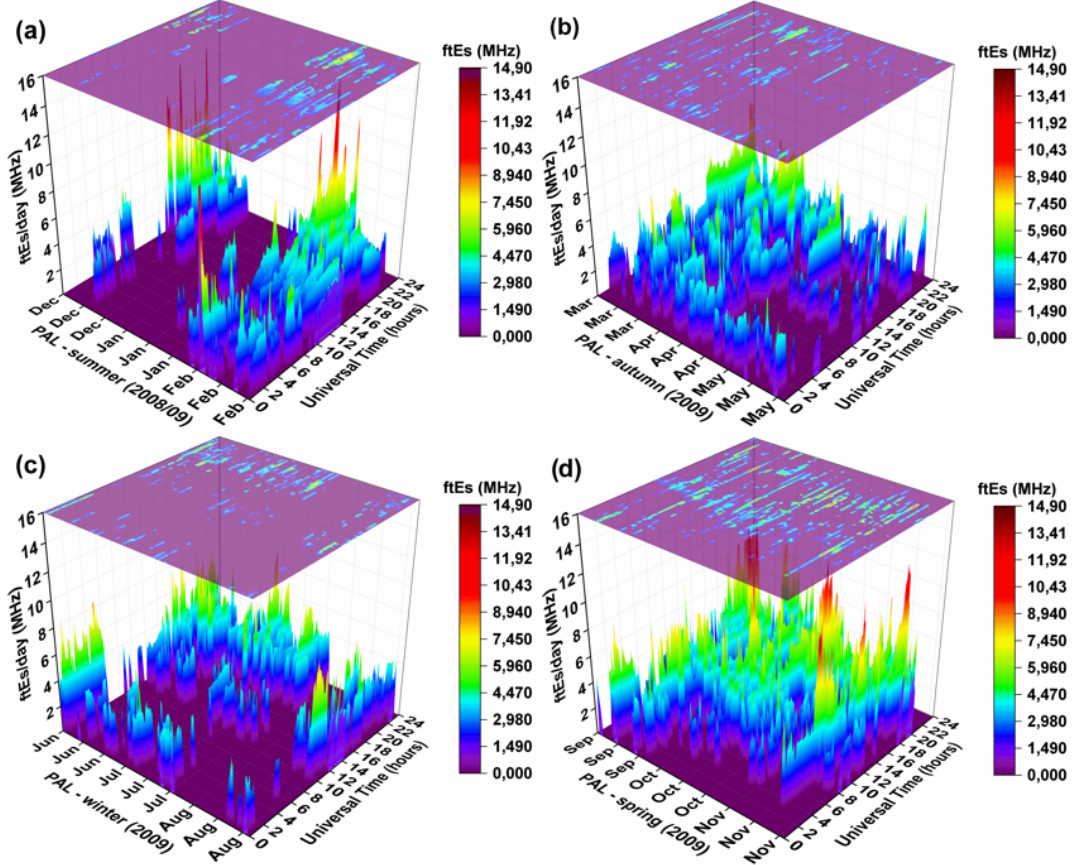
Figure 5. The 3D color map surfaces of the E s layer top frequency (ftE s ) distributed per day (in UT) for the summer (a) , autumn (b) , winter (c) , and spring (d) over